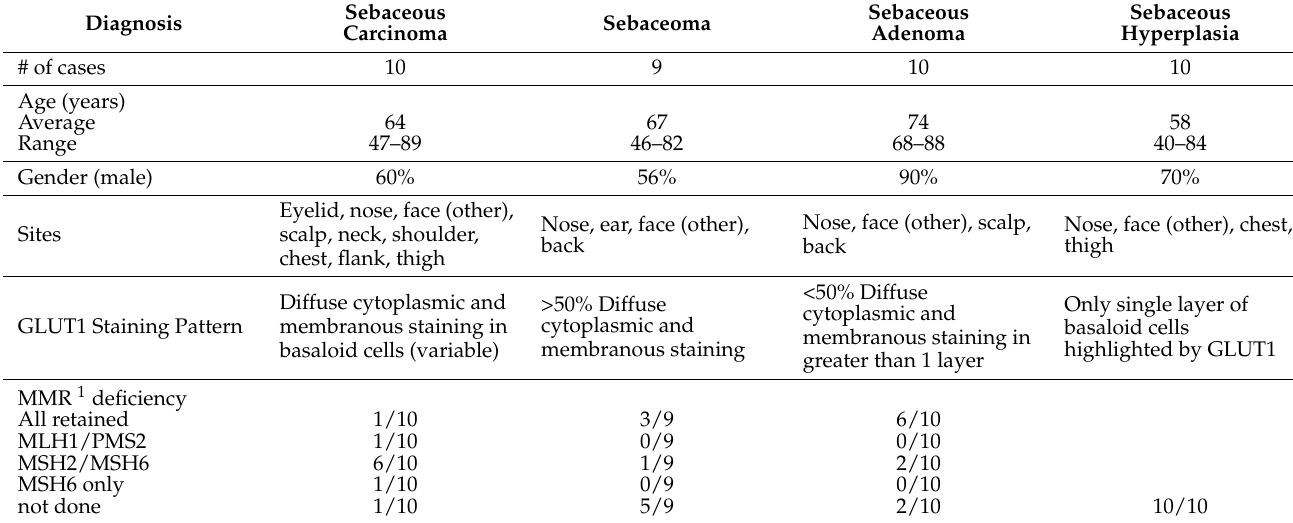
Table 1. Features of cases studied according to diagnosis. Results of mismatch repair deficiency studies are listed where